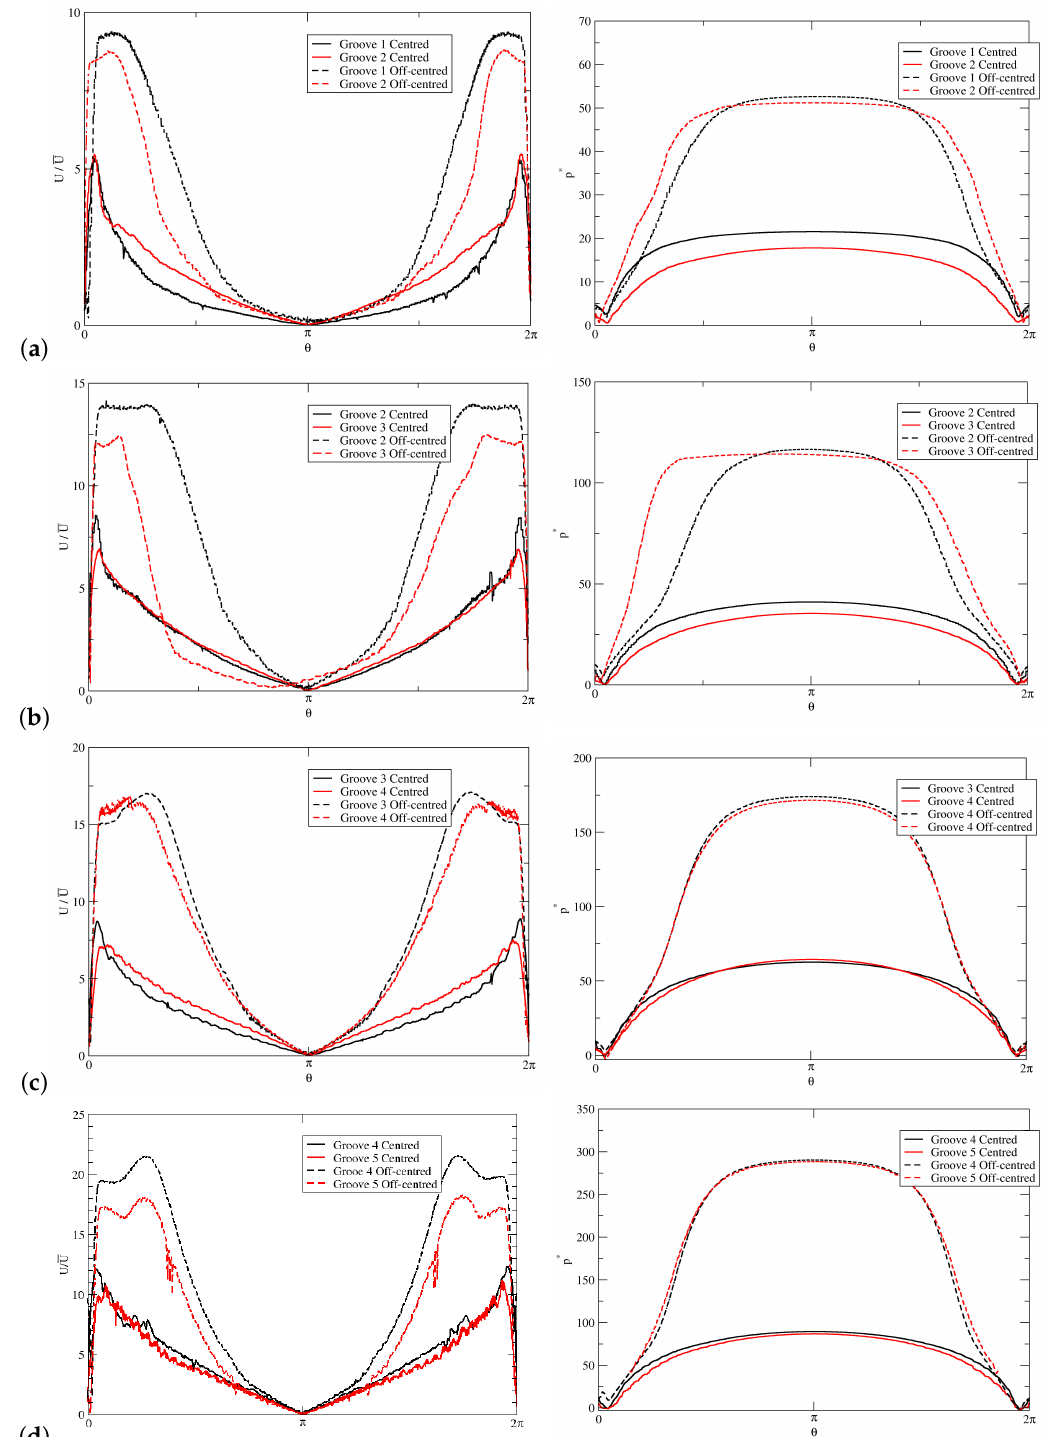
Figure 8. Dimensionless velocity distribution and dimensionless pressure distribution for groove positions R12 ( a ), R23 ( b ), R34 ( c ) and R45 ( d ). Continuous lines are for centered piston and dashed lines are for off-centered